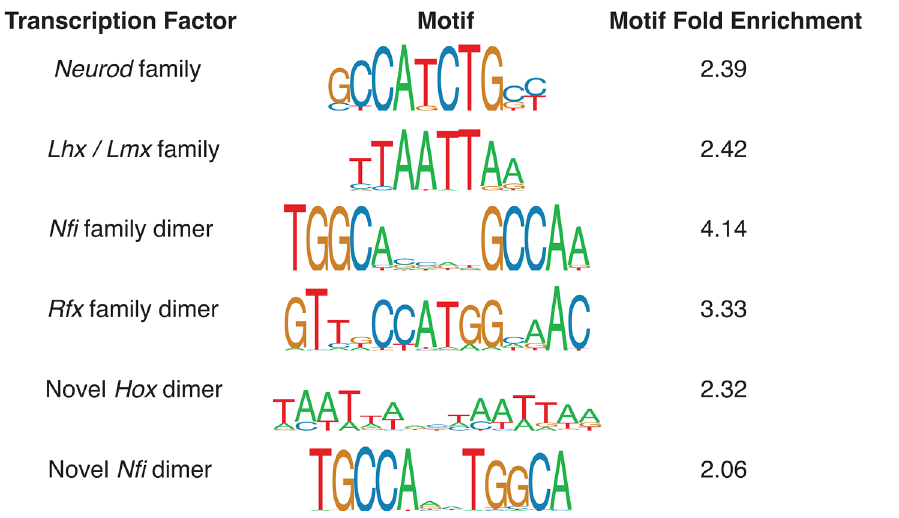
Figure 3. Monomer and dimer transcription factor motif predictions most enriched in the E14.5 p300 ChIP-seq set. Motif fold enrichment is relative to length and GC-matched regions of the mouse genome. Dorsal cerebral wall enhancer function across different species